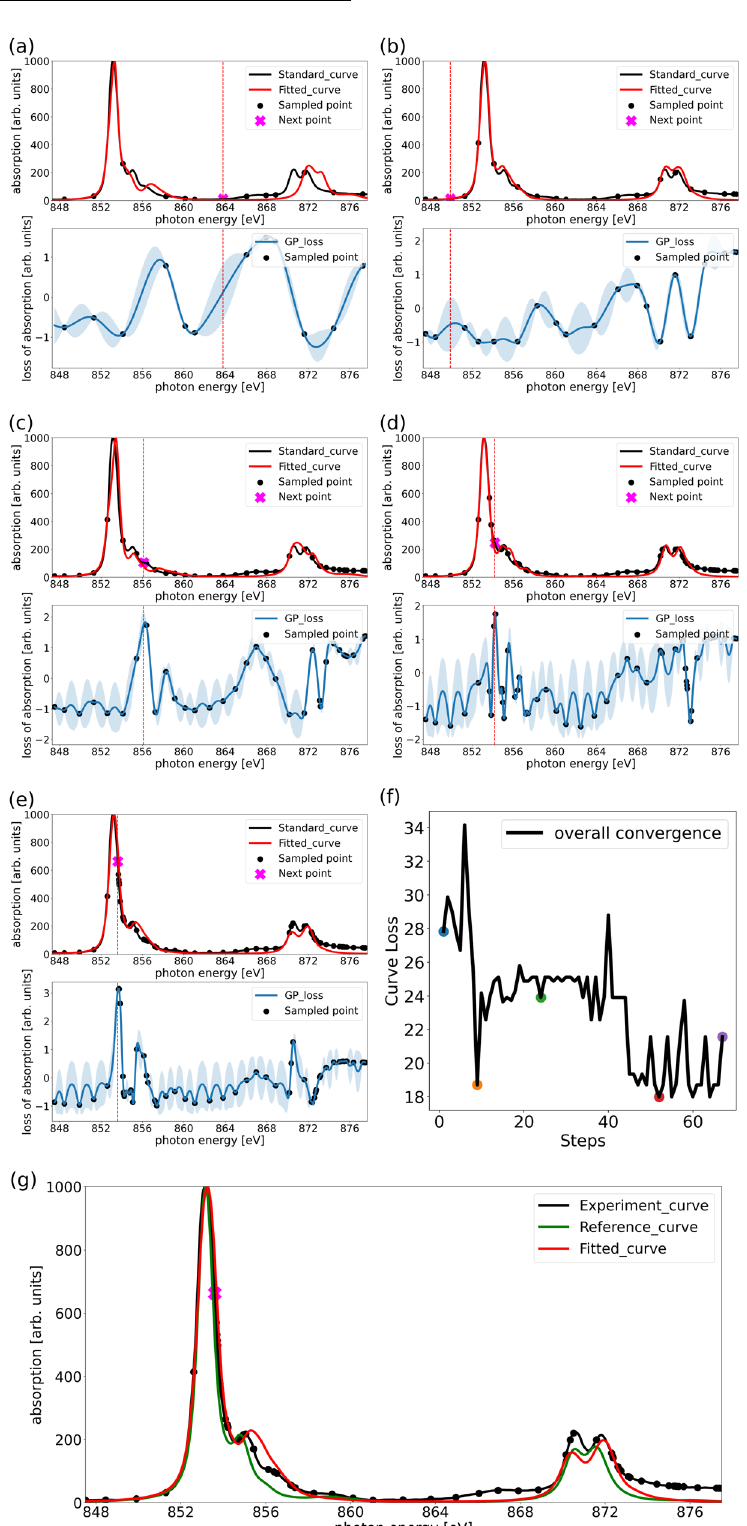
Fig. 4 The fi tting results of the experimental XAS. The fi tting results of the experimental XAS spectrum for different sampling points: a 13 sampling points (Step 1); b 21 sampling points (Step 9); c 36 sampling points (Step 24); d 64 sampling points (Step 52); e 79 sampling points (Step 67); f the convergence of the fi tted XAS curve in comparison with the experimental curve, with the colored dots denote in order the results of Fig. 4a to e; g the comparison of the ABO fi tted XAS curve, the experimental curve, and the reference